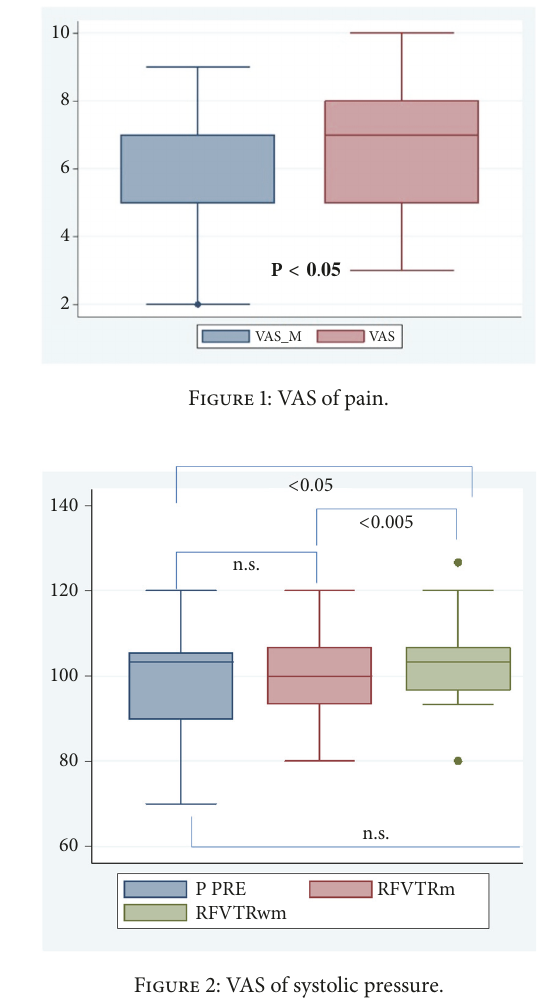
Figure 2: VAS of systolic